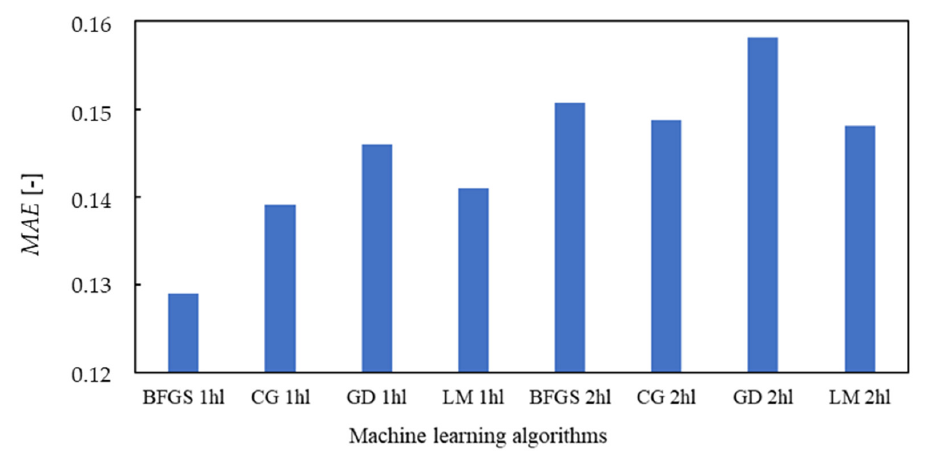
Figure 17. Comparison of models for predicting the pull-off strength of the surface layer f h due to the value of MAE .